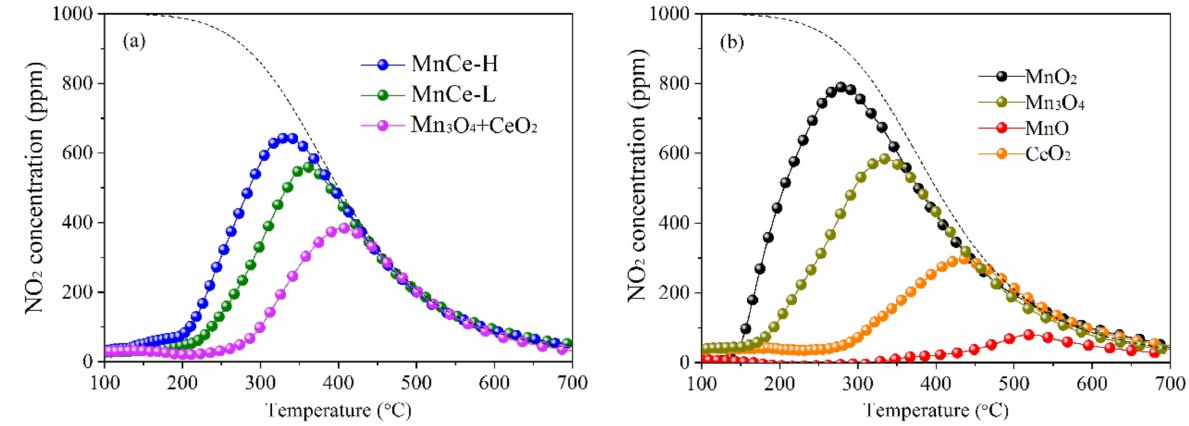
Figure 1. NO 2 evolution during NO-TPO tests over ( a ) Mn 0.15 Ce 0.85 O 2 − δ mixed oxides and ( b ) reference oxide catalysts. Reaction conditions: NO = 1000 ppm, O 2 = 10%, N 2 in balance, GHSV = 30,000 h − 1